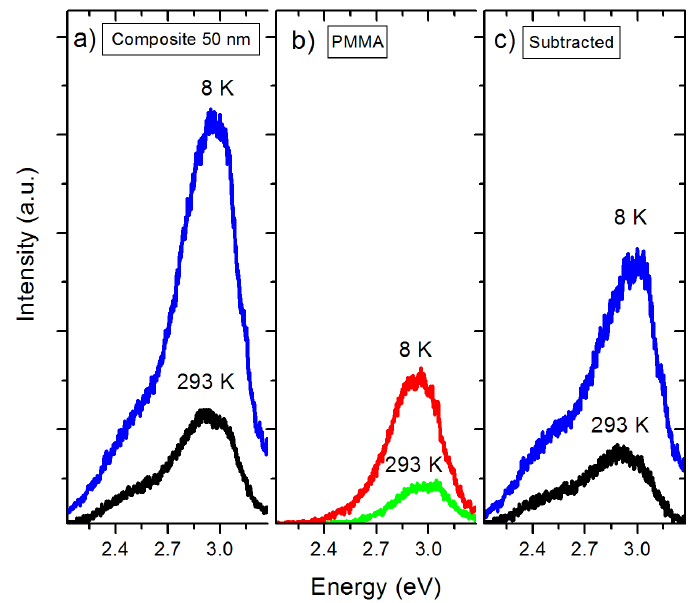
Figure 8. PL spectra of ( a ) Nanocomposite film; ( b ) PL of pure PMMA film of equivalent thickness; ( c ) Nanocomposite with PMMA contributions